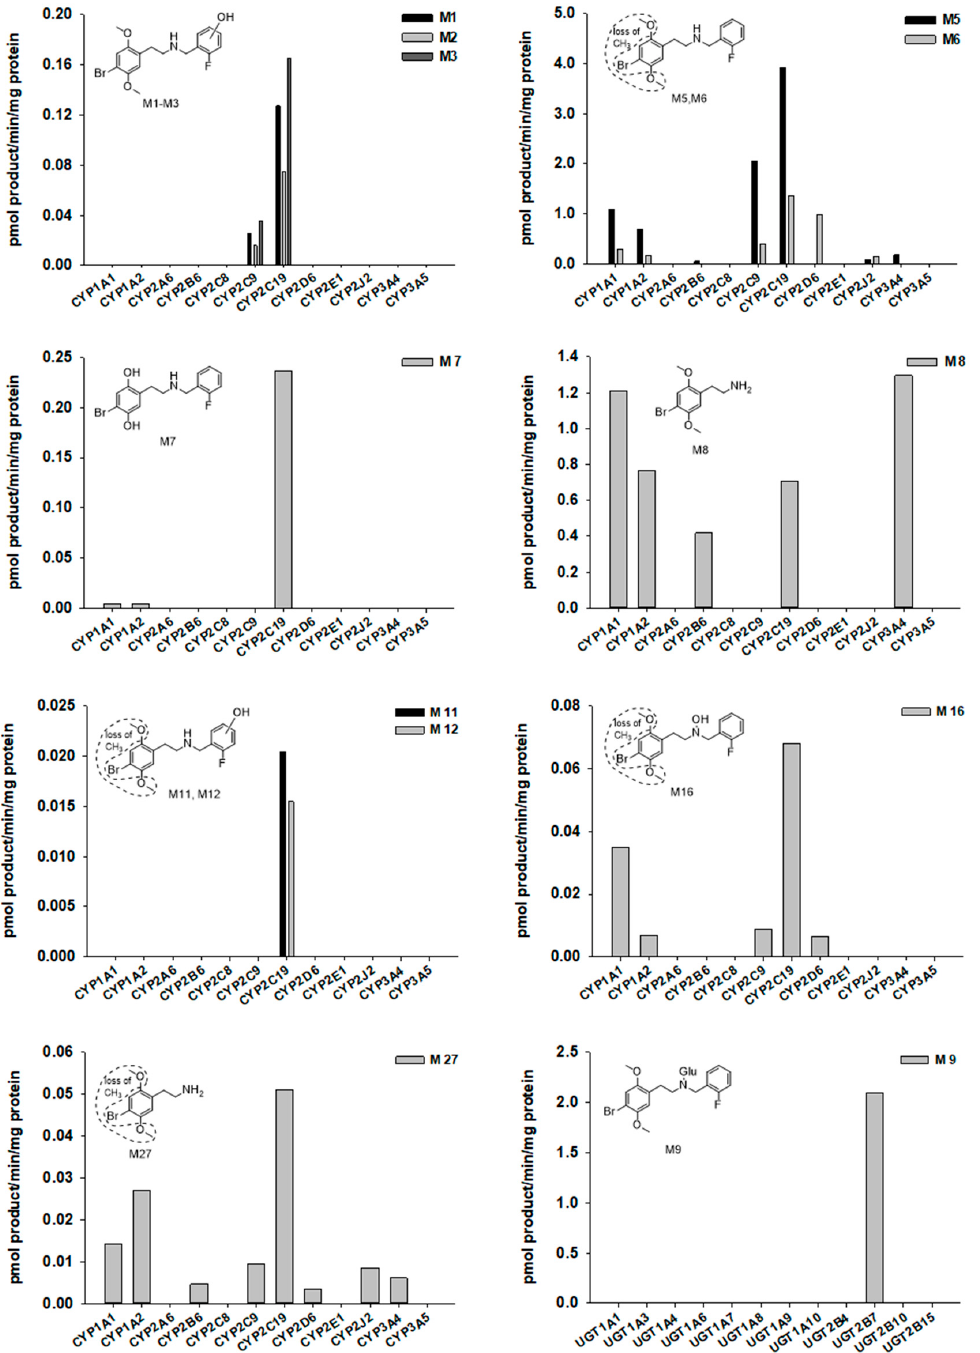
Figure 4. Formation rates of several 25B-NBF metabolites obtained from incubation of 25B-NBF with human cDNA-expressed CYPs 1A1, 1A2, 2A6, 2B6, 2C8, 2C9, 2C19, 2D6, 2E1, 2J2, 3A4, or 3A5, and UGTs 1A1, 1A3, 1A4, 1A6, 1A7, 1A8, 1A9, 1A10, 2B4, 2B7, 2B10, or 2B15. No data means that